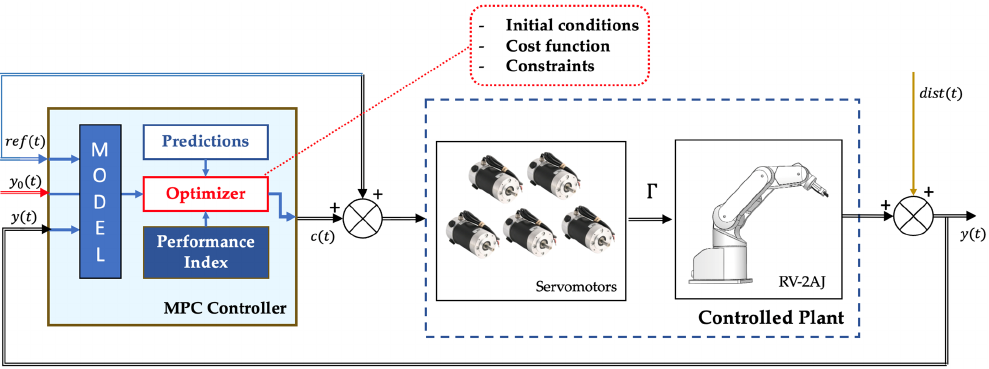
Figure 5. The closed loop control of MPC.